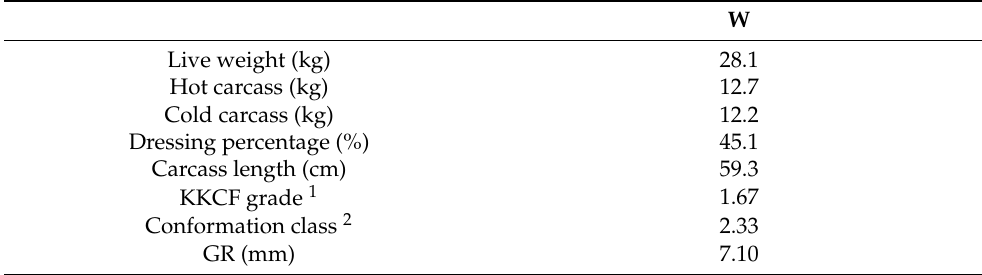
Table 1. Lamb liveweight and carcass characteristics at weaning.